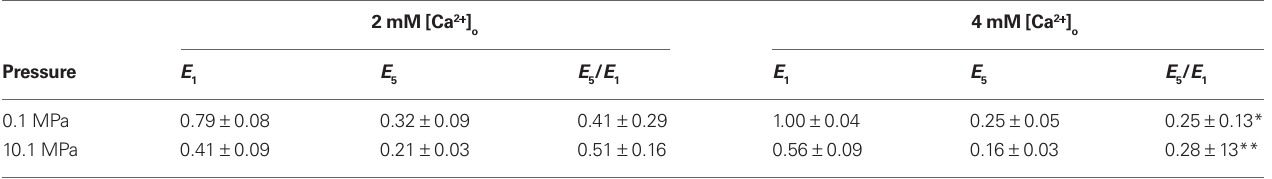
on fePSPs produced during five stimuli trains at 50 Hz. o